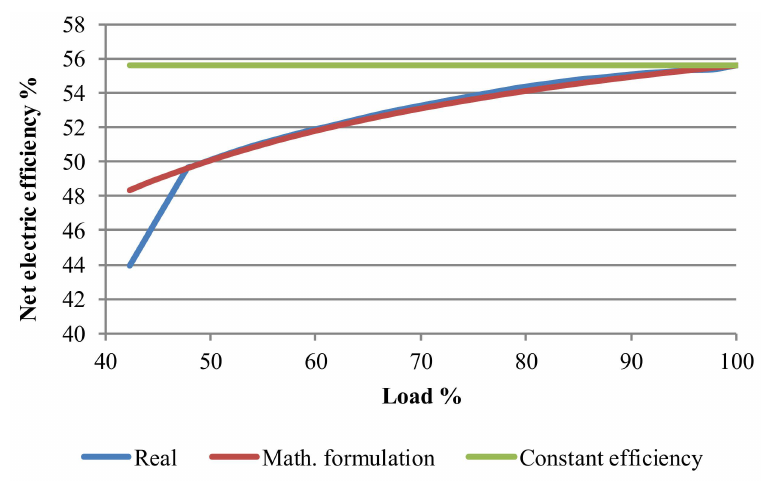
Figure 1. Comparison between the curves of the e ffi ciency as from the proposed mathematical formulation, models featuring constant e ffi ciency, and a real